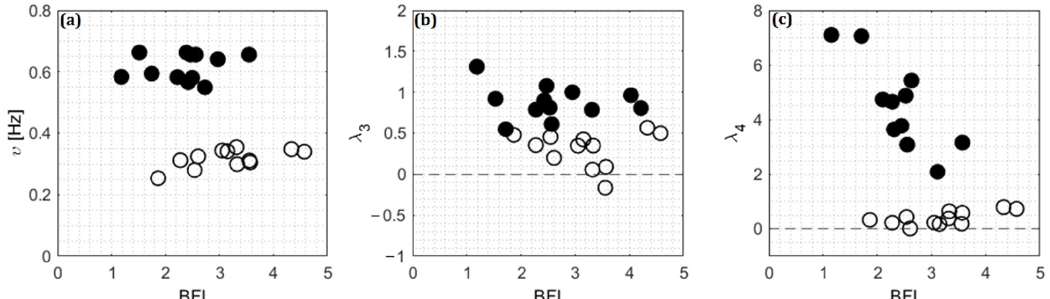
Figure 7. Dependence of spectral bandwidth, skewness and kurtosis on BFI parameter. Open sym ‐ bols: ( a ) the initial spectral bandwidth 𝜐 , ( b ) the initial skewness λ 3 , ( c ) the initial kurtosis λ 4 . Solid symbols: ( a ) the maximum spectral bandwidth, ( b ) the maximum skewness, ( c ) the maximum skew ‐ ness.